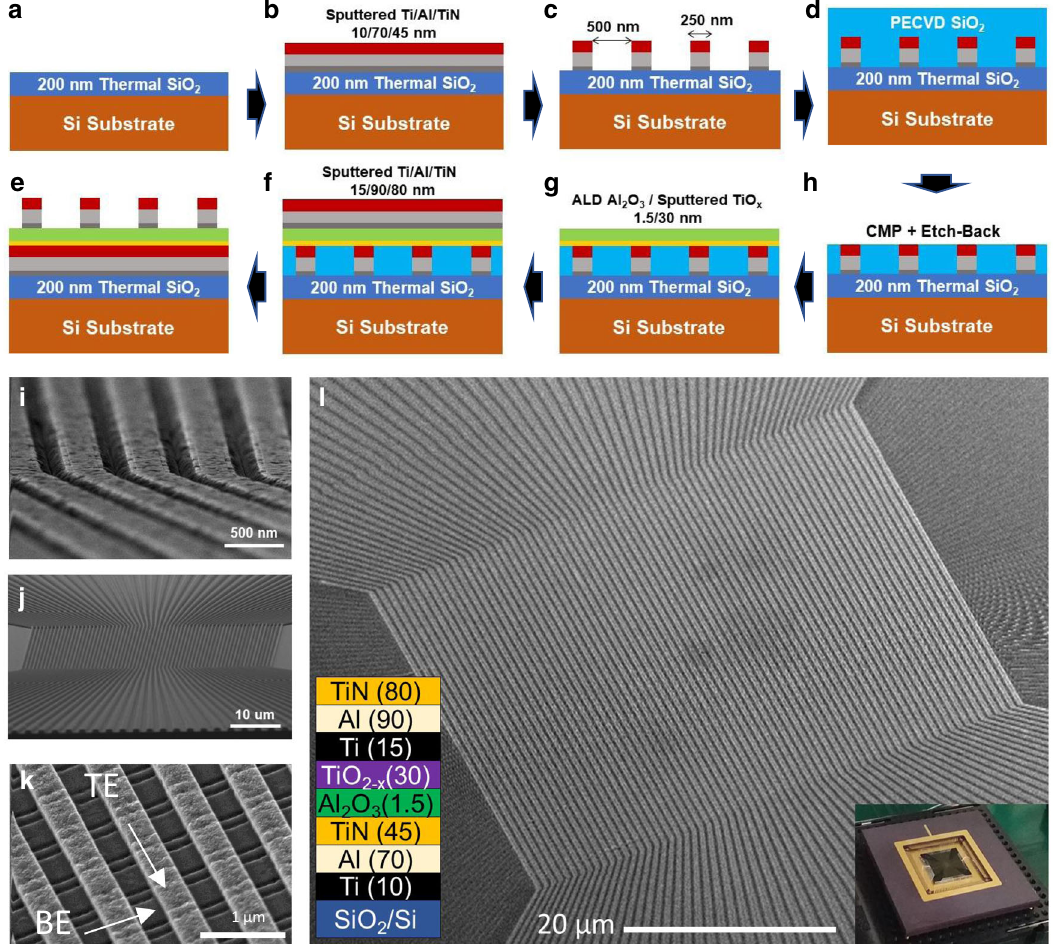
Fig. 1 Device fabrication details. a – h Growth and patterning process steps (see “ Methods ” section for details). For clarity, panel e shows device cross- section turned out-of-plane by 90 degrees with respect to drawings shown in panels a – d , f – h . Scanning electron microscopy (SEM) images of ( i ) patterned bottom electrodes, ( j ) partially planarized bottom electrodes through chemical-mechanical polishing and etch-back, and ( k ) a fragment of completed crossbar array. l SEM image of the full 64 × 64 memristor crossbar array. Bottom left and bottom right insets show, correspondingly, material layers at the device cross-section with corresponding thicknesses in nanometers, and the packaged